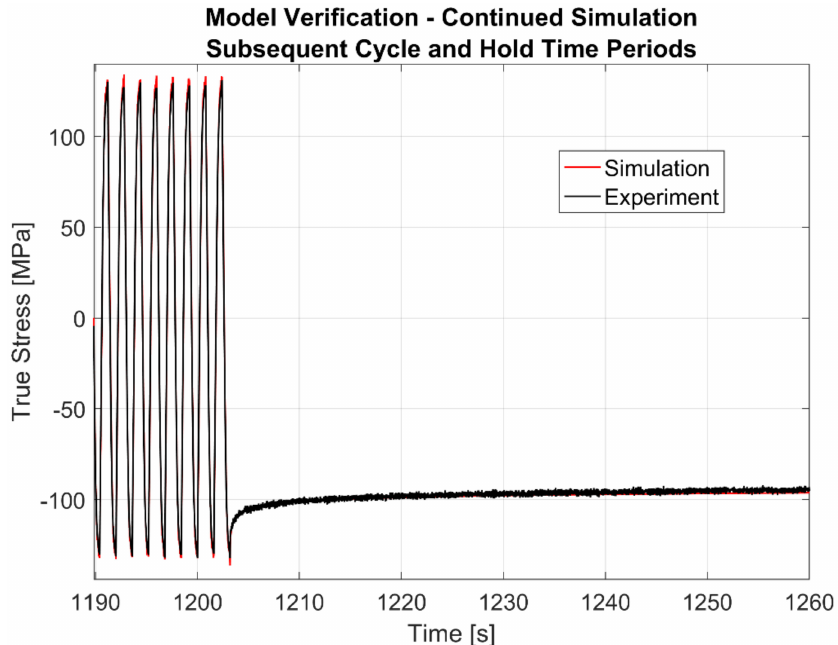
Figure 28. Simulation of continued loading of the second cycle and hold times for verification just before and after the second dwell commences at 250 ◦